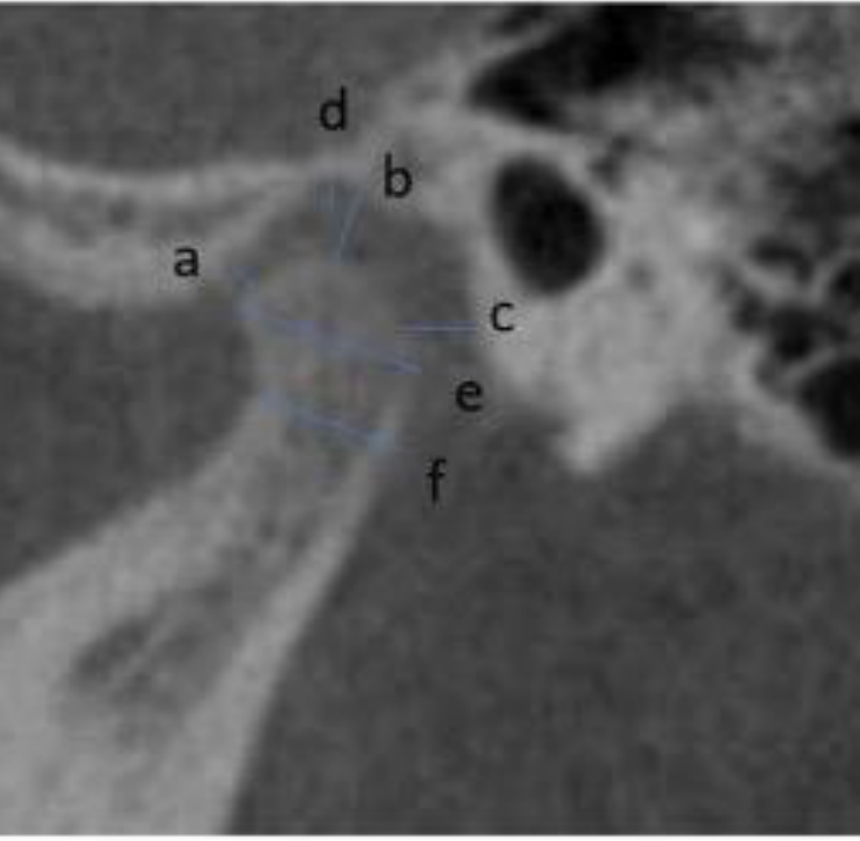
Figure 1. Sagittal view. a—anterior joint space; b—superior joint space; c—posterior joint space; d—depth of the glenoid fossa, e—condylar length; f—condylar neck width.